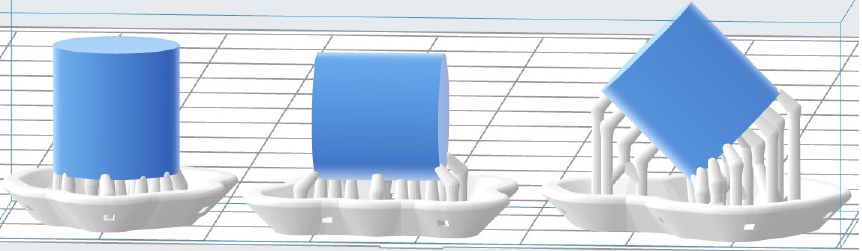
Figure 3. Printing angle variation for compression